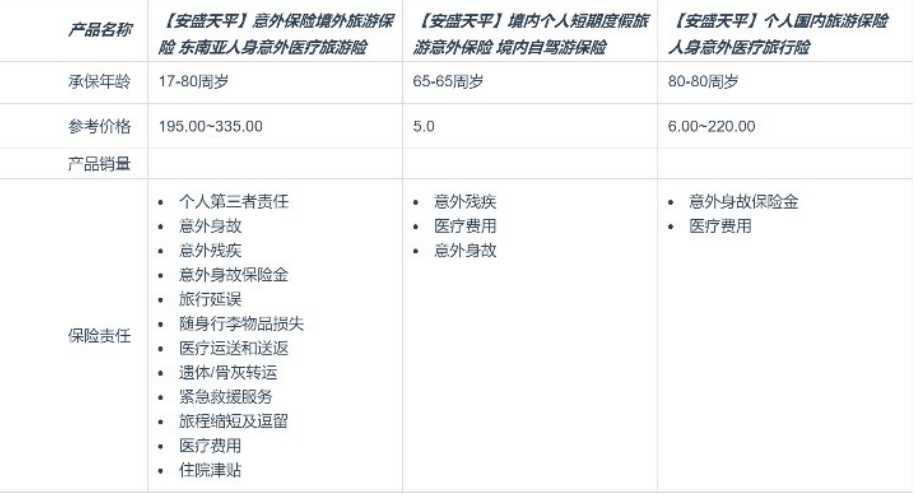
Figure A3. Structured document output. Document information is extracted for structural compari- son.(Chinese